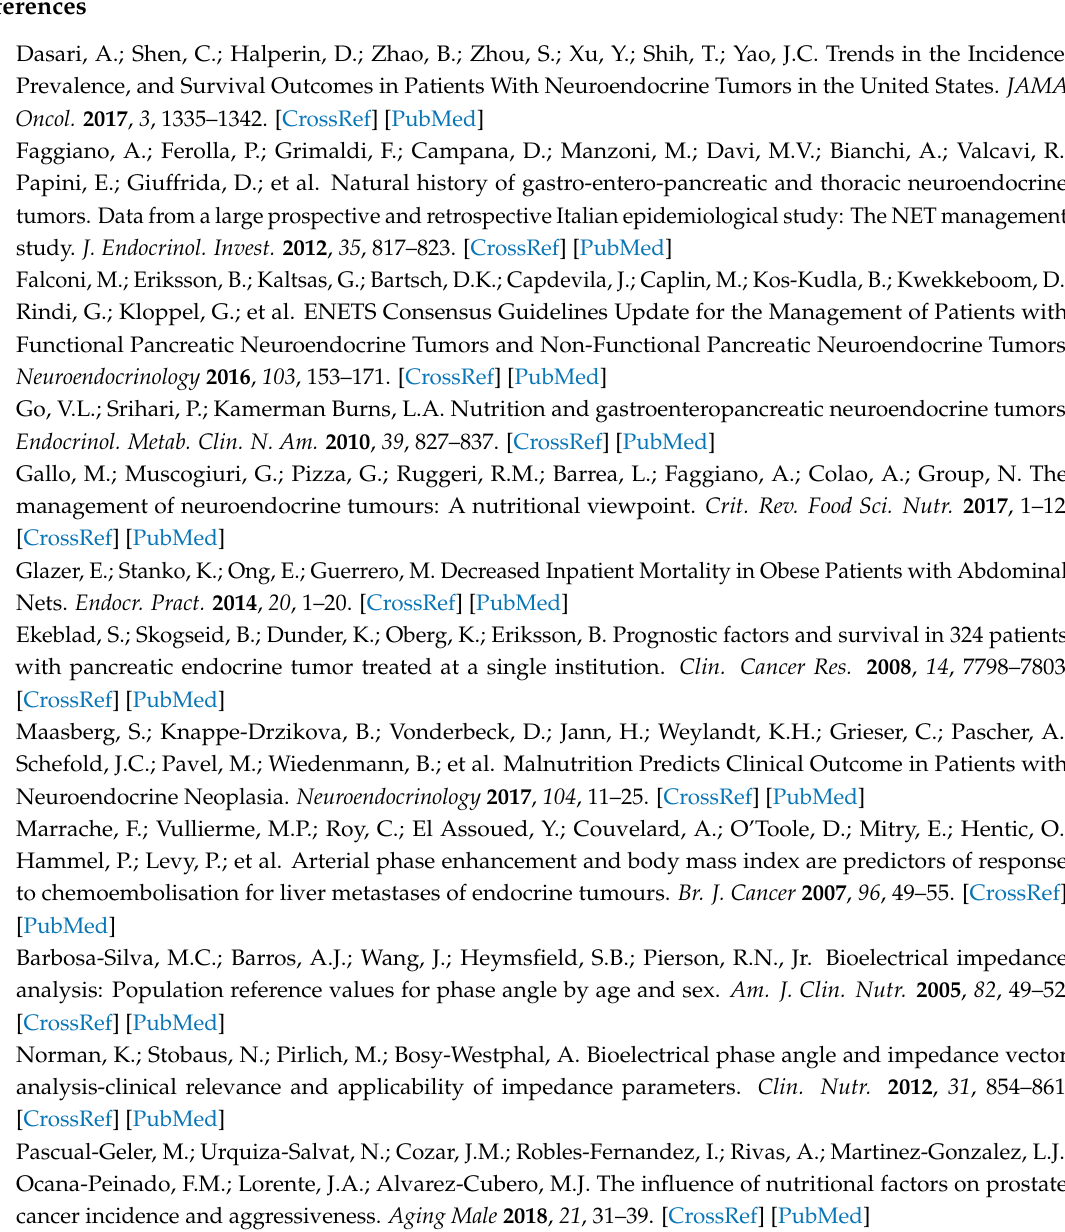
smoking, physical activity and PREDIMED categories, Table S3: Correlations of ki67% index and tumor size with demographic, clinical, metabolic and bioelectrical parameters, Table S4: Multiple regression analysis models (stepwise method) with the tumor aggressiveness and nutritional